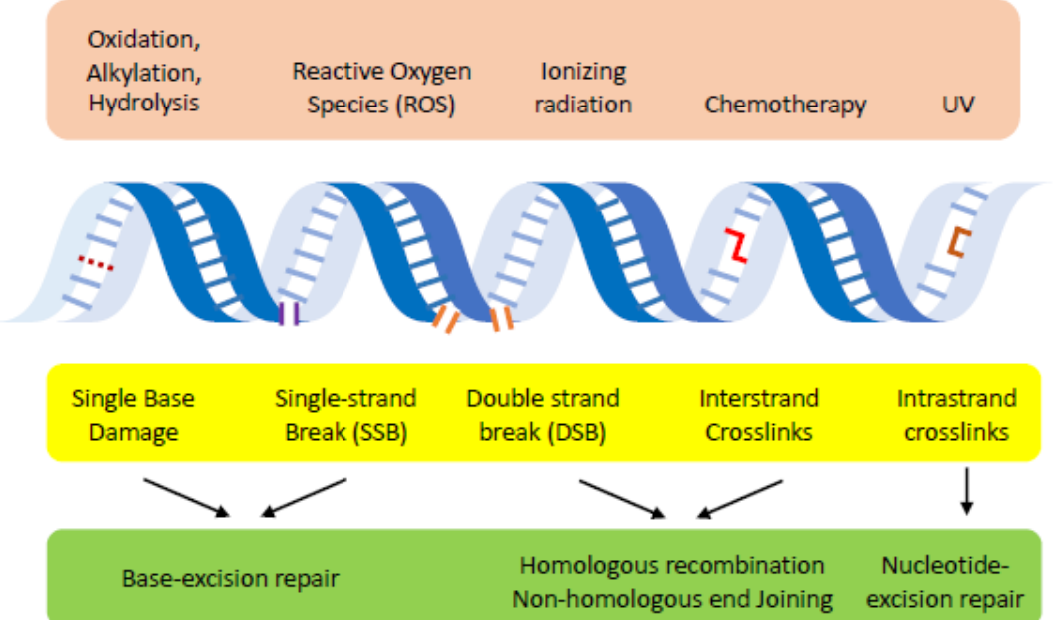
Figure 1. Overview of DNA damage and repair pathways. Environmental agents (i.e., radiation, chemotherapy and reactive oxygen species) or cellular metabolisms (oxidation, alkylation or hydrolysis) induce diverse types of lesions in the DNA. Specific pathways (base excision repair, nucleotide excision repair, non-homologous end joining and homologous recombination) are primarily responsible for repairing these lesions.